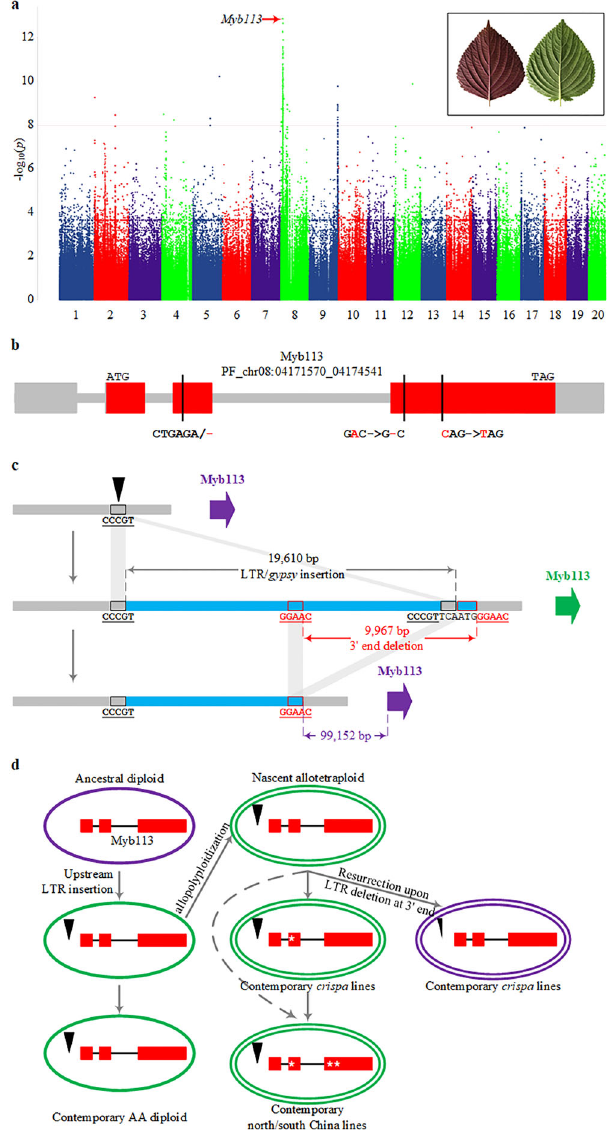
Fig. 5 GWAS analysis of perilla leaf color variation. a Manhattan plot. The strongest associated SNP on chr8 was marked by a red arrow. Dashed horizontal red line indicated signi fi cant p -value threshold of 1.04e − 8 (calculated as 0.05/n). Leaf (abaxial) phenotypes were shown as inset. b Exon structure of the causal Myb113 gene. Coding exons are shown as red boxes, and UTRs in gray. Positions of three coding variants are marked by vertical black lines. c Schematic representation of LTR insertion in diploid and subsequent 3 ′ end partial deletion in allotetraploid. Black box on chromosome (gray line) indicated the 5-nt target site that was duplicated upon LTR integration, and red box on chromosome represented the 5-nt micro-homologous sequences that initiated the 9967-bp segment deletion. Drawn not to scale. d A proposed scenario for evolution of perilla leaf color. Note that the 6-bp in-frame deletion in the 2nd exon of Myb113 (white asterisk) fi rst emerged within the crispa